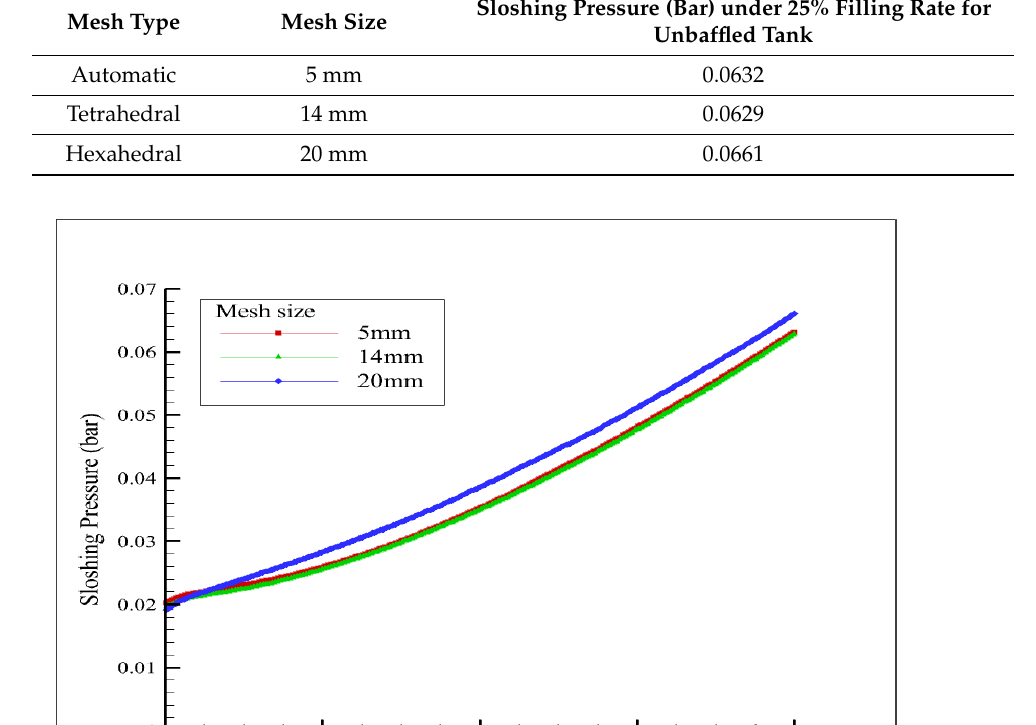
Table 3. Comparison of mesh sensitivity study.